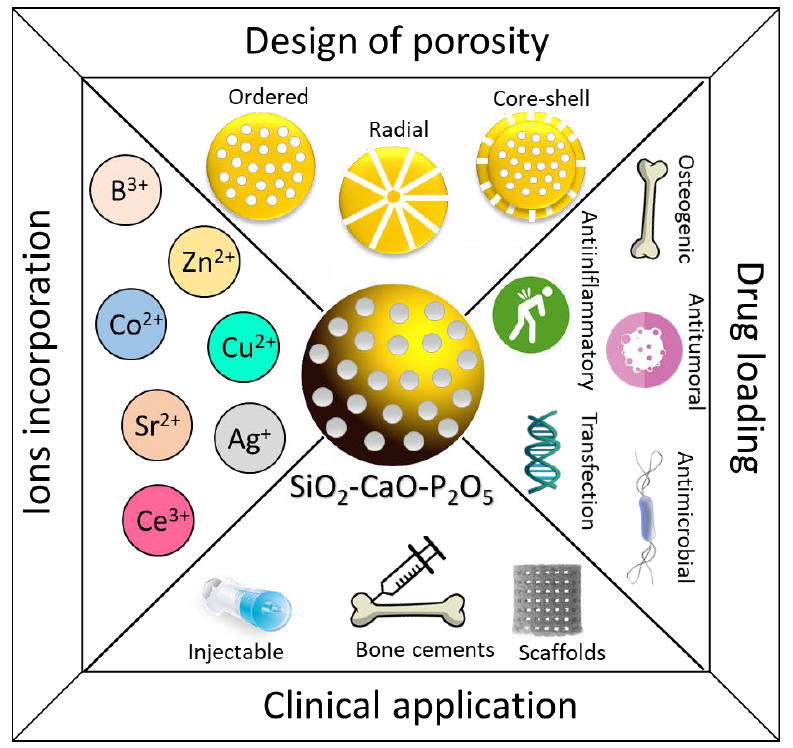
Figure 1. Schematic representation of the different strategies used to optimize the biological behavior of mesoporous bioactive nanoparticles.